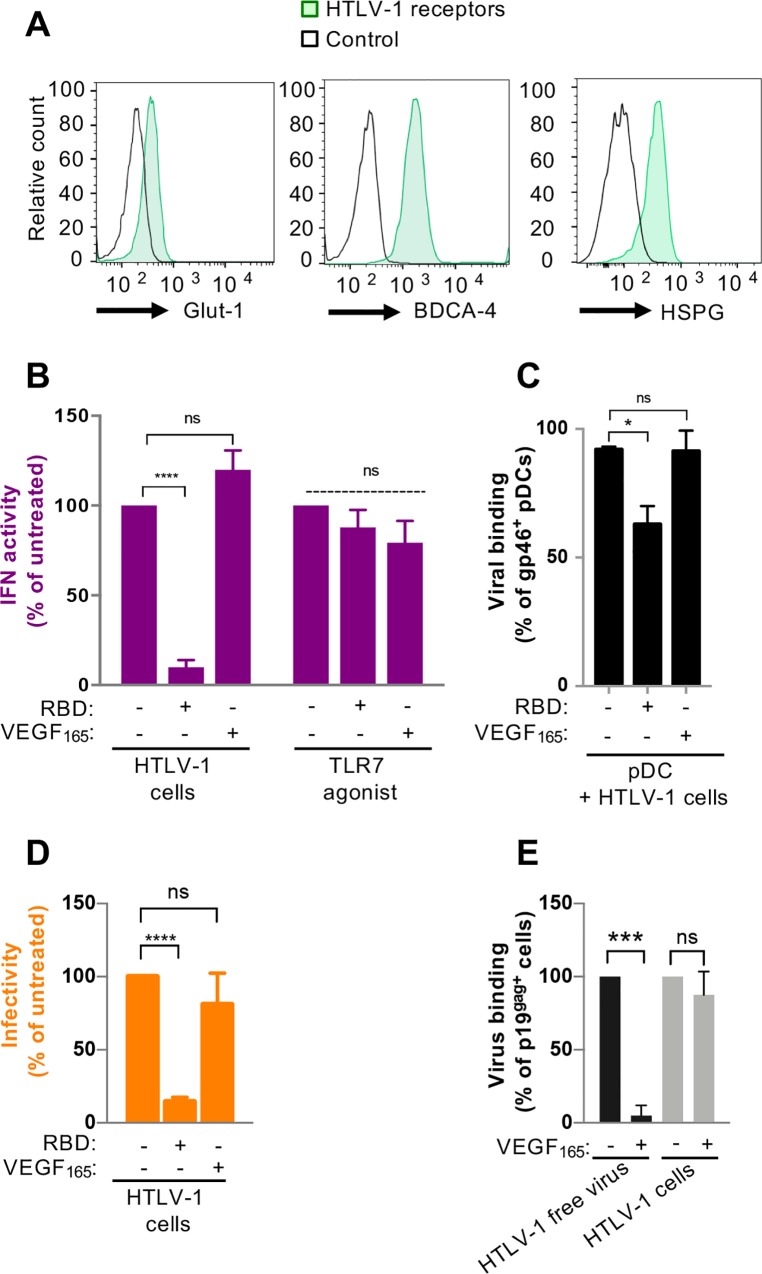
The HTLV-1 receptor Glut-1 is involved in pDC IFN-I production triggered by the sensing of HTLV-1 infected cells, but not Neuropilin-1/BDCA-4.A. Assessment by FACS of the surface expression of the HTLV-1 receptors Glut-1 (revealed with Glut-1.RBD.GFP and controlled with unstained cells), NRP-1/BDCA-4 (revealed with mAb and controlled with IgG isotype) and HSPG (revealed with mAb and controlled with IgG isotype). (representative of 3 independent experiments). B-D. Impact of Glut-1 binding competitor (RBD, 5 μl/105 cells) or NRP-1/BDCA-4 binding competitor (VEGF165, 100 ng/mL) on IFN-I activity in SNs of pDCs co-cultured with HTLV-1-infected cells (C91-PL) (mean ± SD; 5 independent experiments) (B), viral binding was determined by flow cytometry after Env gp46 detection on pDCs surface (mean ± SD, 3 independent experiments) (C), and infectivity transmission levels (mean ± SD; 3 independent experiments) (D), determined as in Fig 1. The results in (C) and (D) are expressed as percentages relative to untreated co-cultures. Asterisks indicate statistically significant differences calculated using ANOVA followed by Sidak’s multiple comparison test: * p> 0.05, **** p< 0.0001; ns: non significant. E. Viral binding as determined by flow cytometry after p19gag detection on Jurkat target cells upon exposure to HTLV-1 cell-free viruses or upon co-culture with HTLV-1 infected cells in the presence or not of NRP-1/BDCA-4 binding competitor (VEGF165, 80 ng/mL). Jurkat cells were differentiated from HTLV-1 infected cells based on their size (see S2C Fig). The results are expressed as percentage relative to untreated conditions (mean ± SD; 2–3 independent experiments). Asterisks indicate statistically significant differences calculated using ANOVA followed by Sidak’s multiple comparison test: *** p<0.001; ns = non significant.